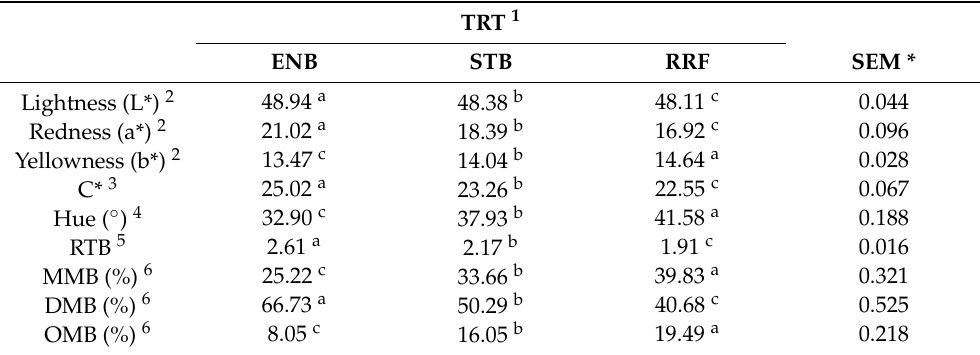
Table 1. Influence of packaging film on color values of vacuum-packaged ground beef during a simulated retail